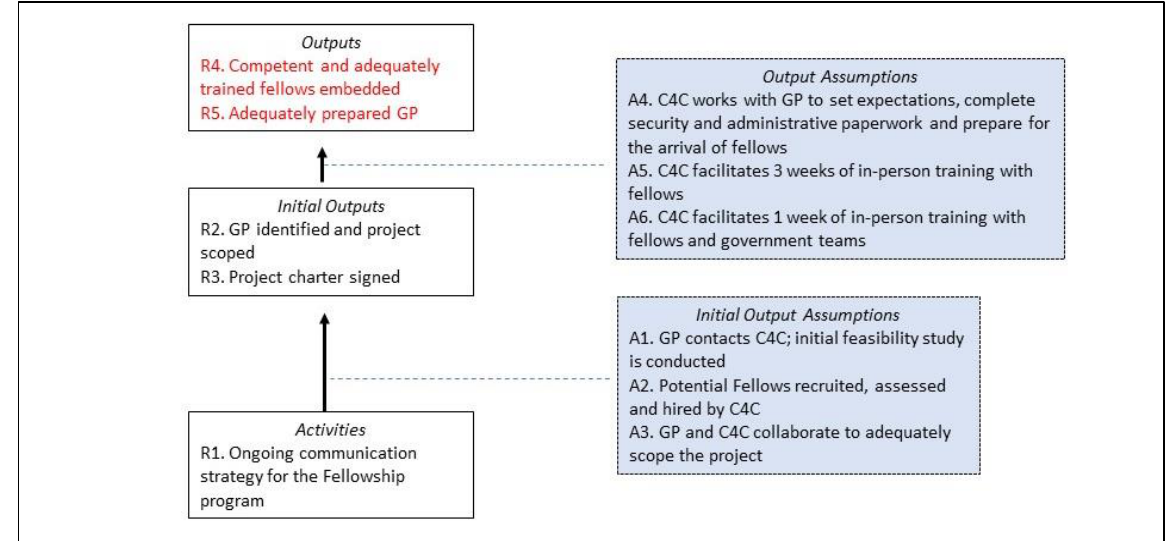
Figure 4: Code for Canada Fellowship Theory of Change Story 1 (C4C pre-fellowship